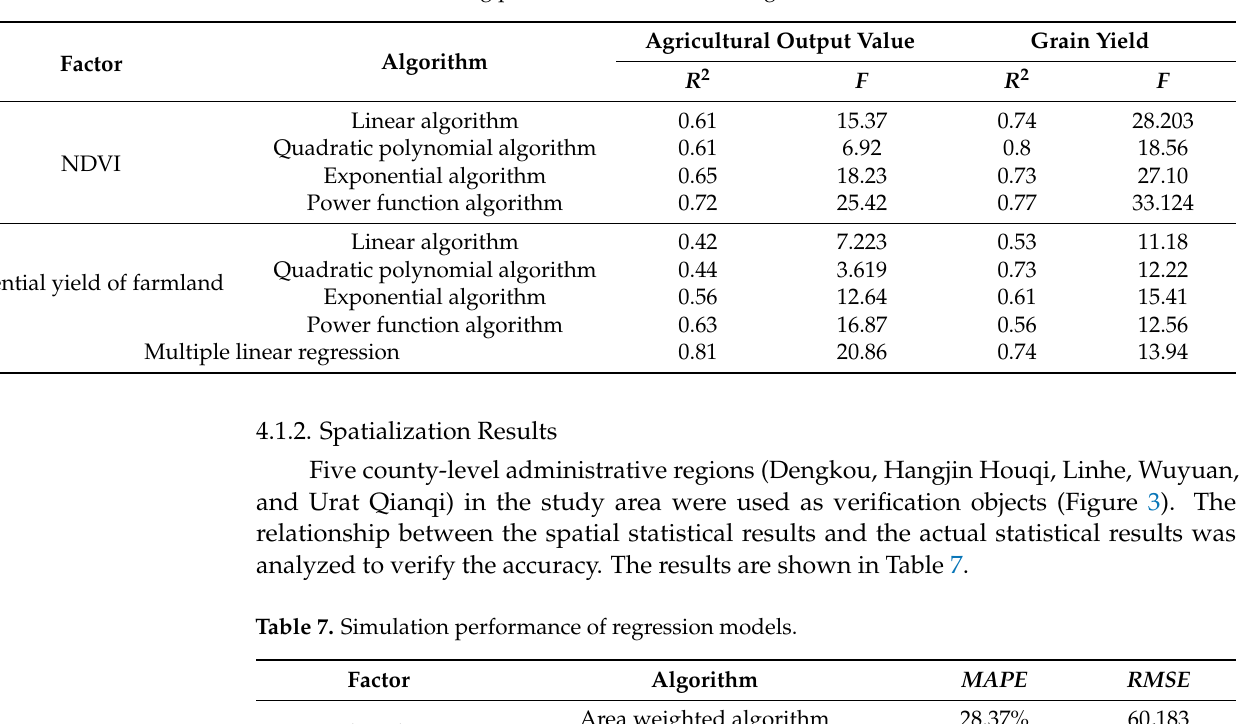
Table 6. The fitting performance of different algorithms.